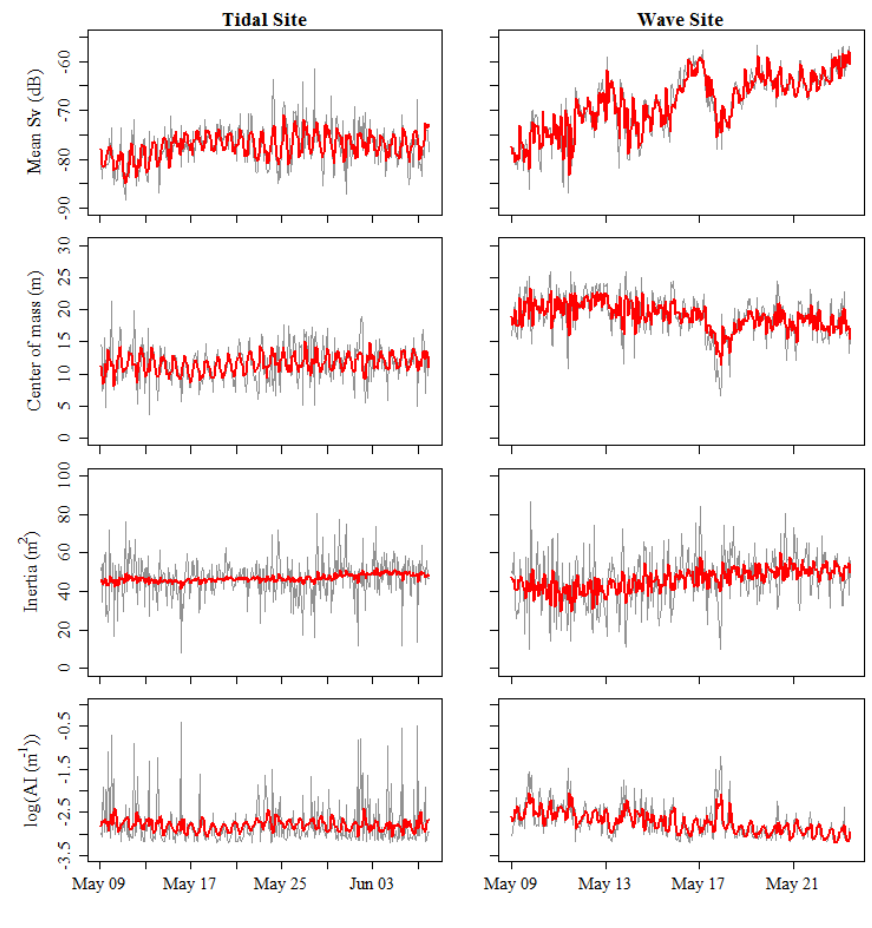
Fig. 6. Regression Autoregressive Moving Average models for mean Sv, center of mass, inertia and aggregation index for a tidal and a wave energy site. Raw data are in grey and in red are shown the mean model